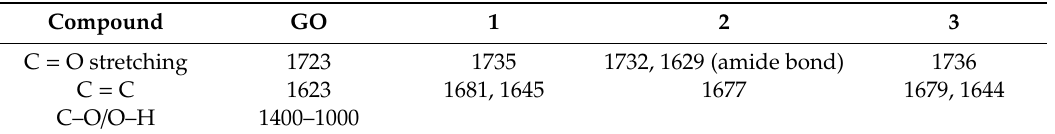
Table 1. Representative FT-IR vibrational frequency (wavenumber, cm − 1 ) of important functional groups for GO, PS 1 , GO–PS 2 , and GO–PS 3 .